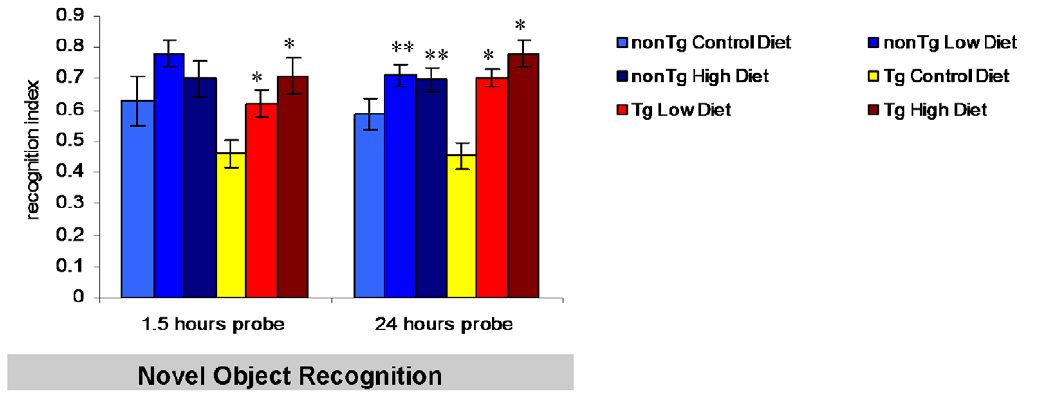
Figure 2. Prevention of cortical memory deficits with medical food cocktail diet in Tg2576 mice. We evaluated treated and untreated Tg2576 and nonTg mice in performance of the primarily perirhinal cortex-dependent contextual task, novel object recognition. Tg2576 mice treated with medical food cocktail had significantly improved recognition indexes at both the 1.5- and 24-h probe trials, compared to vehicle Tg2576 mice (1.5 hour probe trial (low diet p , 0.05, high diet p , 0.01; 24 hour probe trial (p , 0.01 for both low and high combination diets). Notably, nonTg mice treated with medical food cocktail showed improved recognition indexes at the 24-h probe compared to vehicle nonTg mice (p , 0.05 for both low and high combination diets). Error bars indicate SEM. * indicates significance for control Tg2576 mice vs. medical food cocktail treated Tg2576 mice, ** indicates significance for control nonTg mice vs. medical food cocktail nonTg mice.